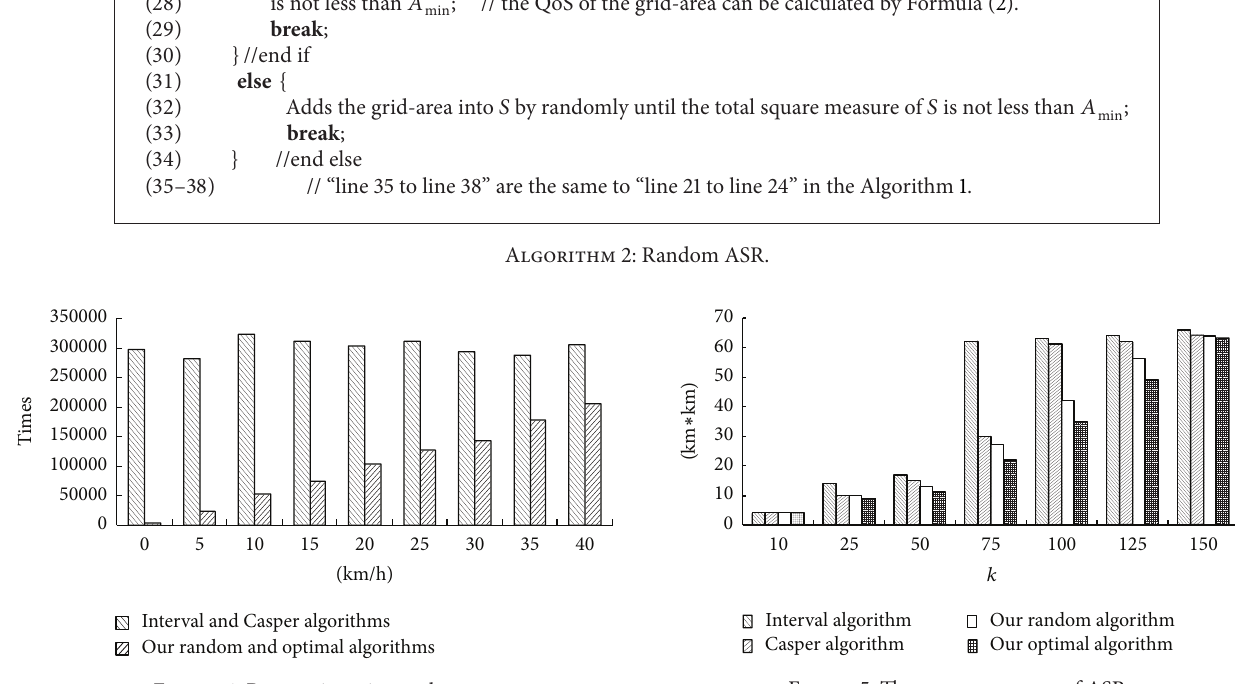
Figure 4: Report times in one hour.